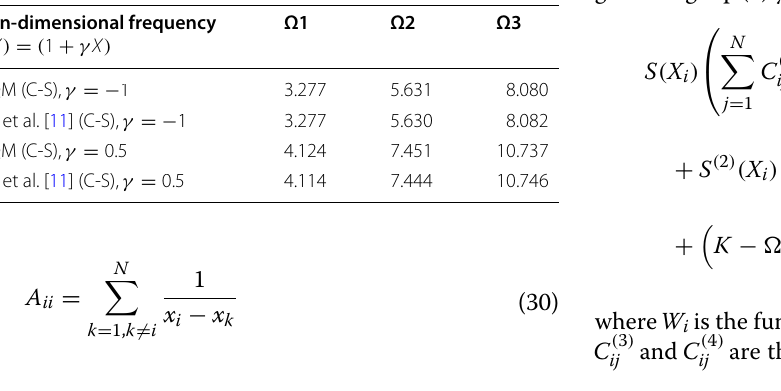
Table 2 Comparison between DQM and numerical values for the first three non-dimensional frequencies of non-uniform beams